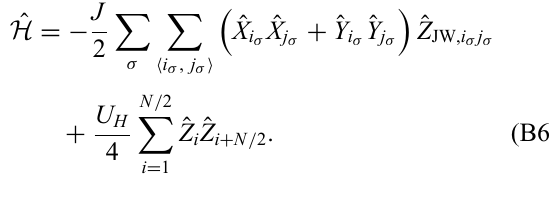
Fig. 13. The interaction term is transformed into the Ising